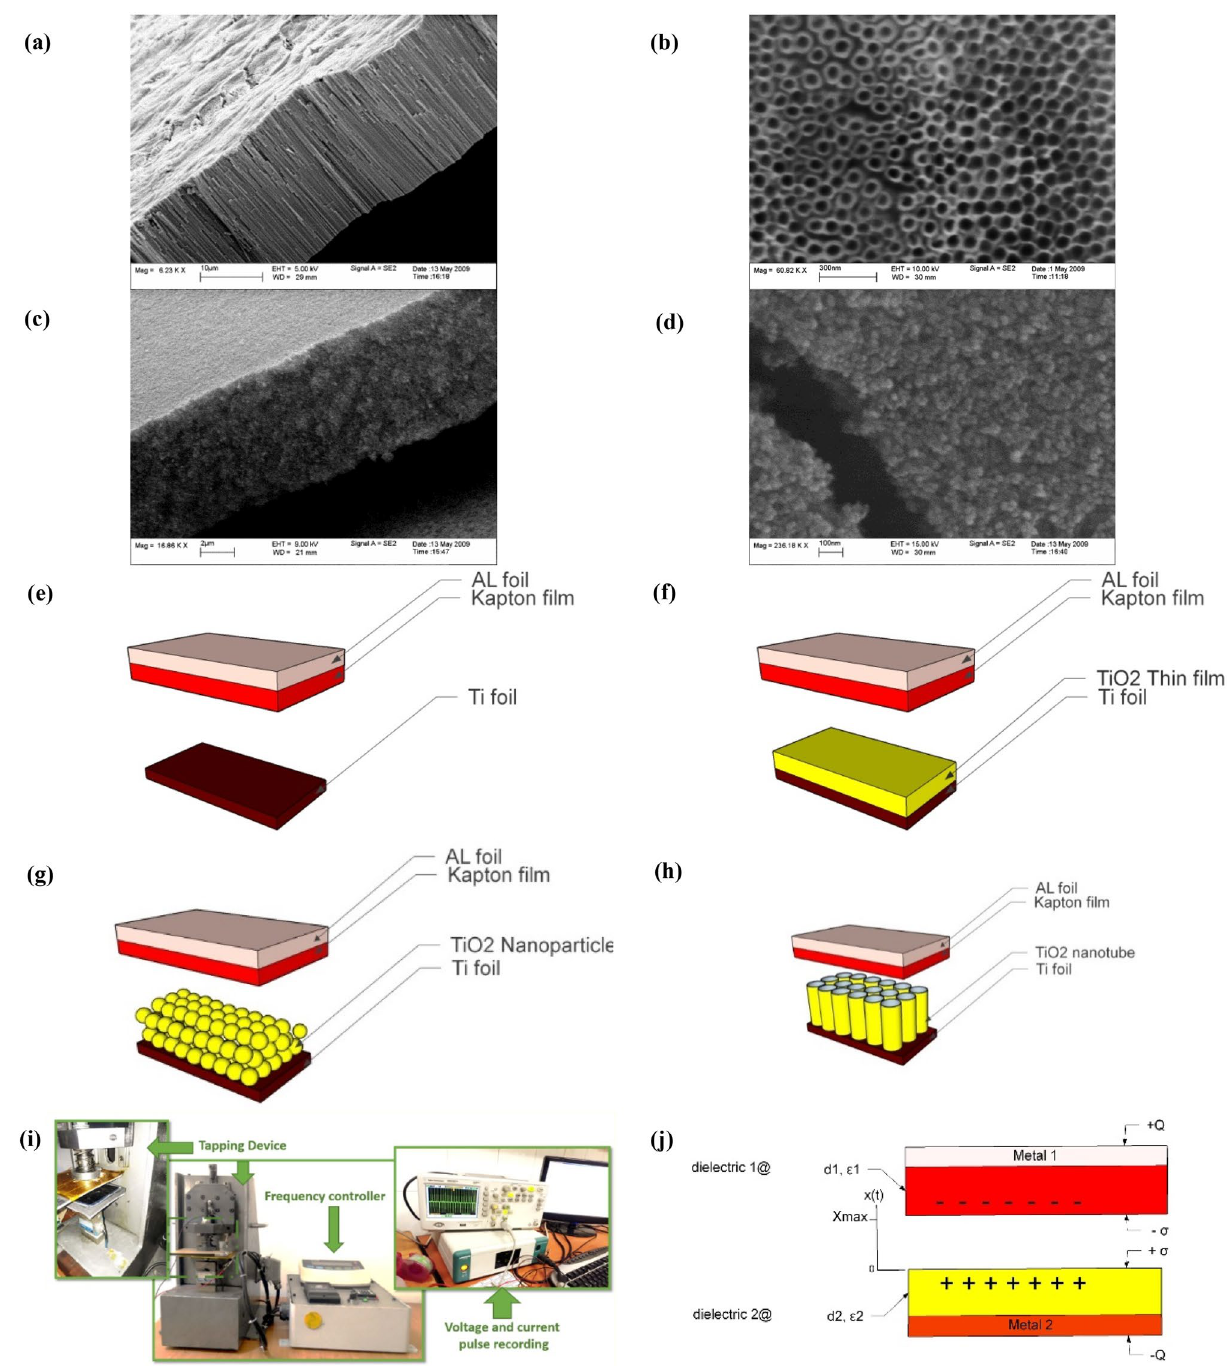
Figure 1. The structural design of the TENG based on the different morphology in the triboelectric active layer. ( a,b ) SEM images of TiO 2 nanotube film and ( c,d ) TiO 2 nanoparticle film. The structure of fabricated TENG based on different active layers: ( e ) Ti foil, ( f ) TiO 2 thin film, ( g ) TiO 2 nanoparticulate film, and ( h ) TiO 2 nanotube array film. ( i ) Experimental setup. ( j ) Schematic diagram of TENG in numerical simulation and its related